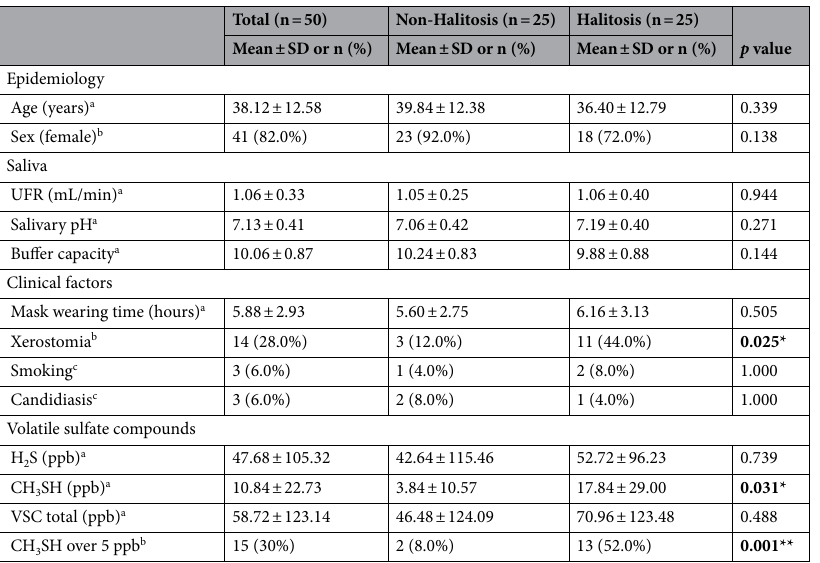
Table 1. Demographics, clinical characteristics, and volatile sulfide compounds level. a: Results were obtained using Mann–Whitney U test; b: chi-square test (two-sided); c: Fisher’s exact test (two-sided). p value was considered as significant when p value < 0.05 (* p < 0.05, ** p < 0.01). The significant results are shown in